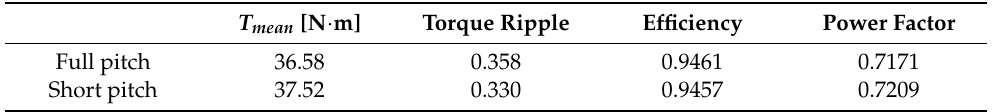
Table 3. Performance comparison between single-layer full pitch and double-layer short pitch winding, for the best rotor configuration.